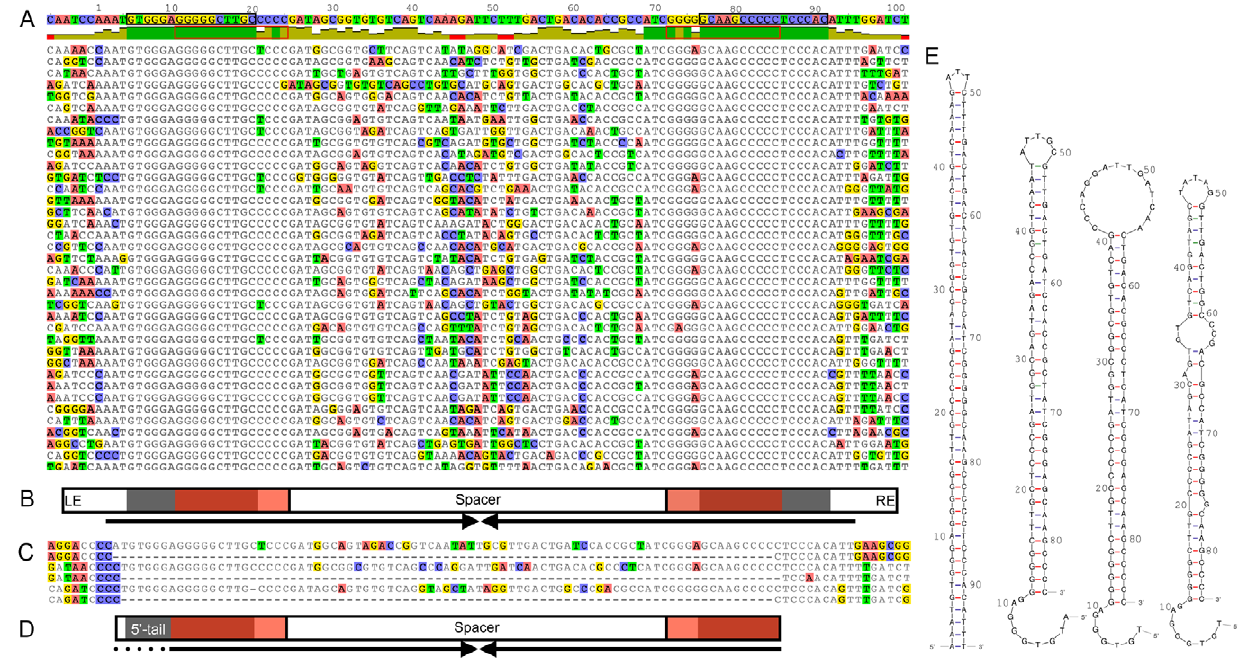
Figure 4. General organization and predicted secondary structure of REPINs. ( A ) Alignment of 101 GI REP doublets forming hairpins (REPINs) from SBW25 (37 are shown) shows a symmetrical (palindromic) organization comprised of two highly conserved regions separated by a spacer. Top line shows the consensus sequence followed by a graph displaying identity to the consensus (green denotes 100% identity). Two invariant regions of 16 bp are found in the left and right ends (LE, RE). These sequences are organized as inverted repeats and define the most abundant 16-mer in the SBW25 genome (black box). Each 16-mer overlaps a GI REP sequence (red box). ( B ) General REPIN features including LE and RE, each comprised of a highly conserved 16-mer (black) overlapping a REP sequence (red), with the two ends separated by a spacer. For a GI doublet the distance between the first residues of the two invariant 16-mers is 71 bp. Complementary bases permit formation of a hairpin structure (arrows). ( C ) Three excision events detected from Illumina sequencing reads reveal a putative transposition intermediate. Full-length sequences show three genomic regions located between 2,577,312–2,577,231, 3,857,520–3,857,439 and 5,683,545–5,683,624 bp on the SBW25 genome, each of which contains a REPIN. The partial sequences below each genomic region are Illumina reads from which the REPIN has been excised (see also Figure S6). ( D ) Cartoon of the excised region indicating putative transposition intermediate. Note the 5 9 -tail, which generates an asymmetrical sequence. ( E ) Secondary structure prediction for the consensus GI REPIN shows that the conserved bases on each side can pair resulting in a long hairpin ( E , left). Predictions for transposition intermediates in the same order as the alignments in ( C ): the second, third and fourth hairpin correspond to the first, second and third alignment. The single stranded 5 9 -tail is free to pair with a complementary sequence.